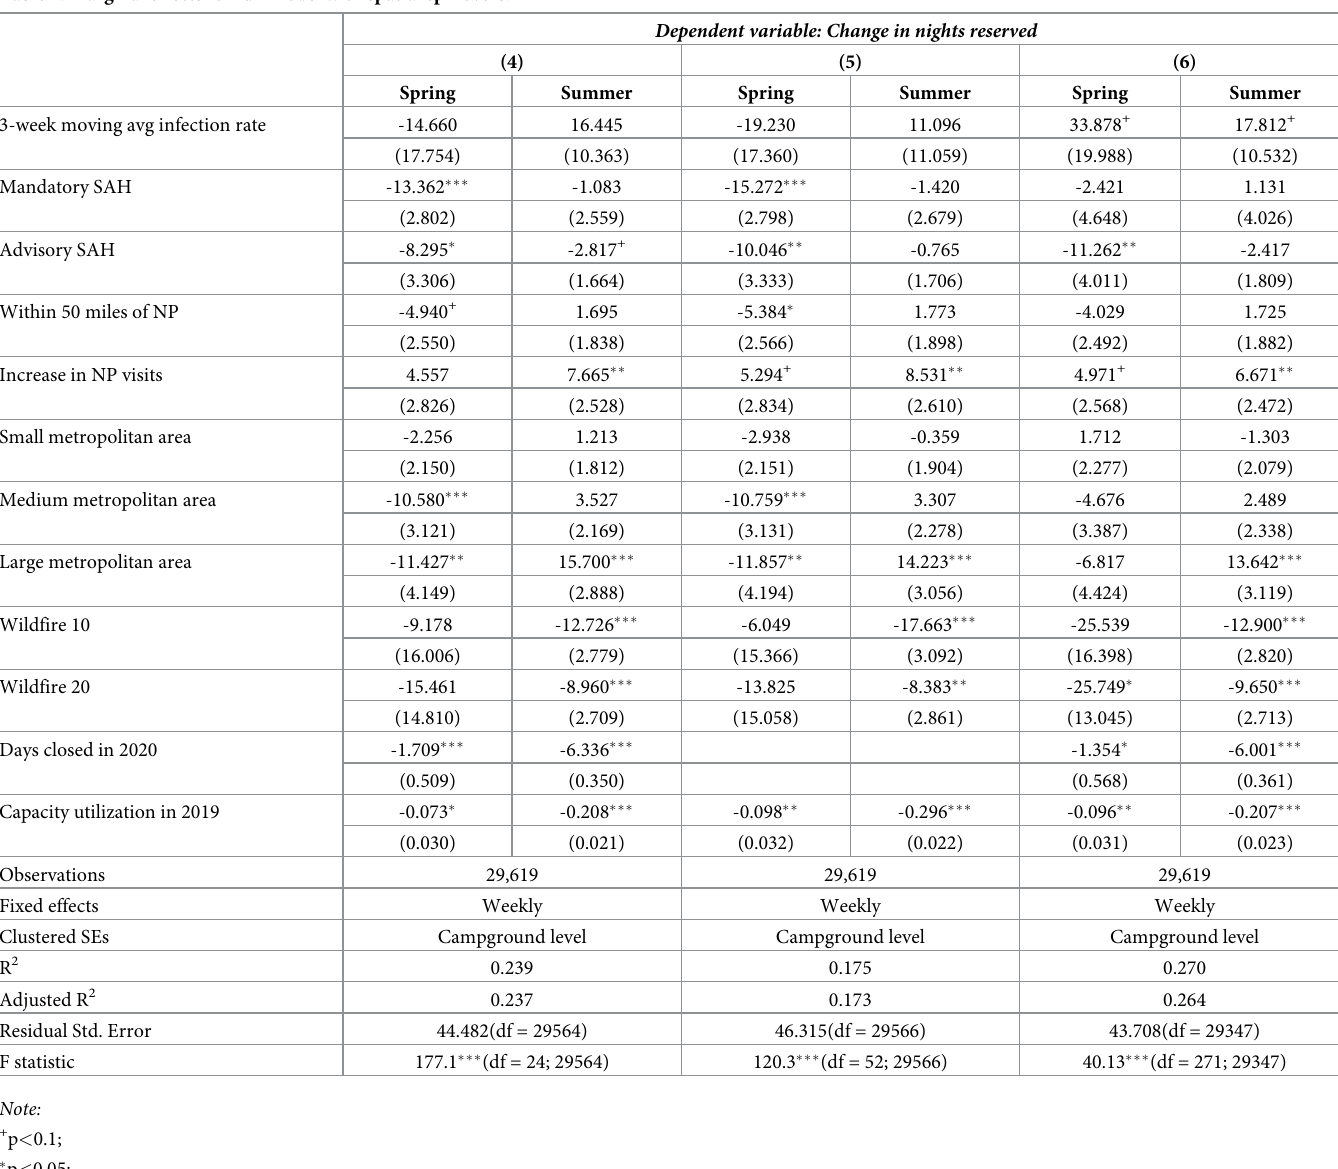
Table 4. Marginal effects for full model with spatial